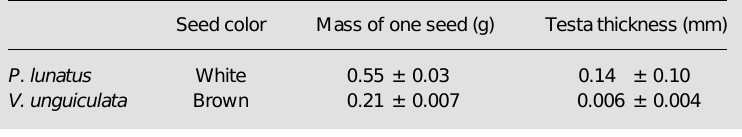
Table 2 - Tannic acid, HCN, protein and vicilin (or phaseolin) contents (as percent fresh weight) of testa and cotyledon tissues of Phaseolus lunatus and Vigna unguiculata (EPACE-10)